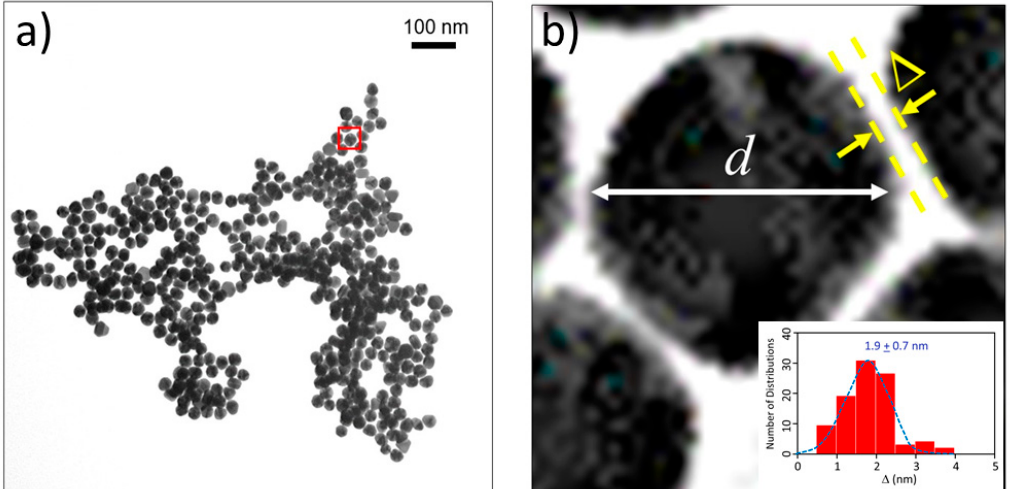
Figure 2. ( a ) A TEM (transmission electron microscopy) image of 30 nm gold colloidal particles coated with β 2m at pH 4. The scale bar for 100 nm is shown as a guide. ( b ) A magnified section of the red box showing the diameter of a gold colloid d and the distance between the adjacent colloidal particles ( ∆ ). (Inset): A typical histogram showing the ∆ and the observed numbers of the distribution. The distribution was fit by a Gaussian profile and shown by a dotted curve. This histogram is for the β 2m-coated 30 nm gold colloid.